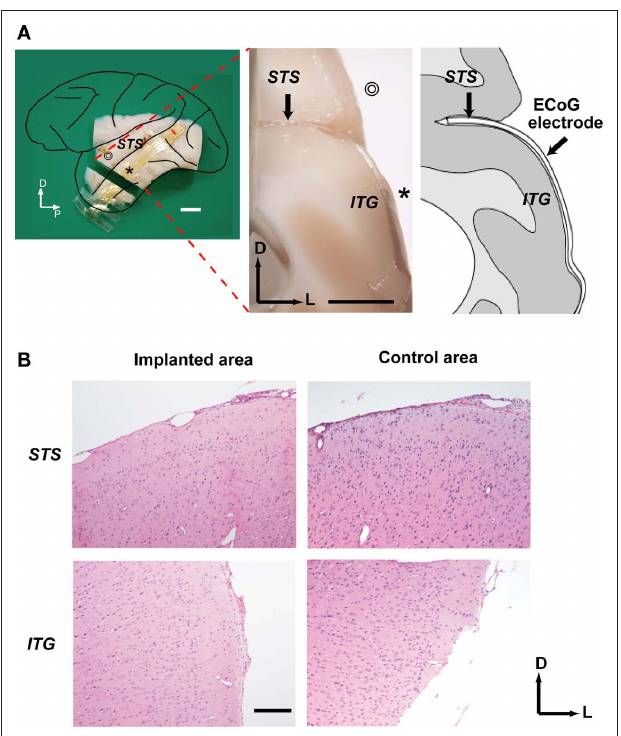
FigurE 6 | Histological investigation of the ECog electrode implant. (A) Left : Lateral view of the left hemisphere indicating the position of the coronal section shown in the middle.   and * denote STG and ITG, respectively. Middle : Coronal cross-section of the brain showing electrode implantation. Right : Line drawing of cross-section. Scale bars indicate 5 mm. P , posterior; D , dorsal; L , lateral; STS , superior temporal sulcus; ITG , inferior temporal gyrus; (B) Microscopic view of the coronal sections. The sections from the implanted area of the STS (upper left) and ITG (lower left) as well as the adjacent unimplanted area were stained with hematoxylin and eosin. A scale bar indicates 300 μm.